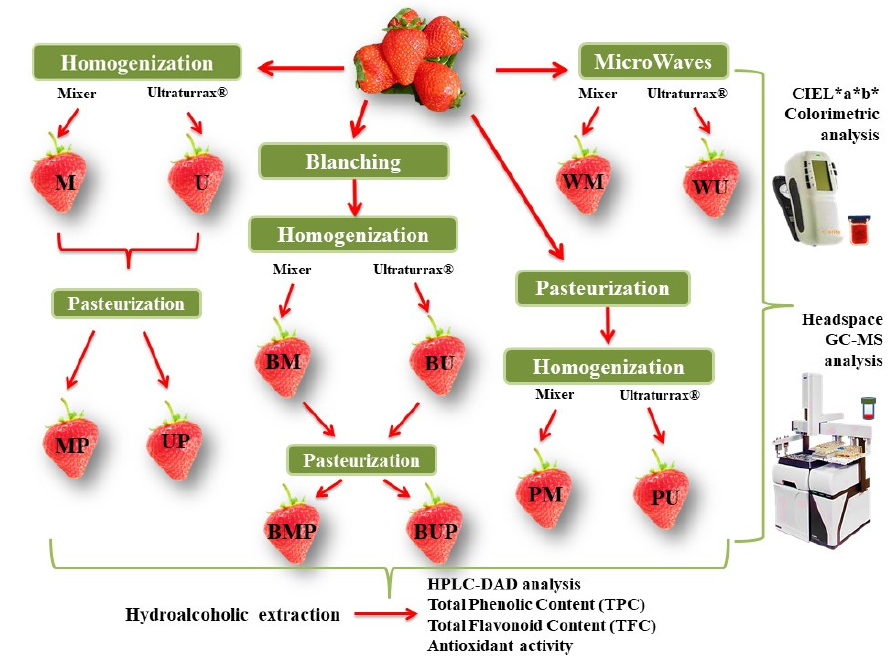
Figure 1. Flow chart of the applied treatments and the performed analyses on fully ripe fresh or defrosted Clery strawberries.